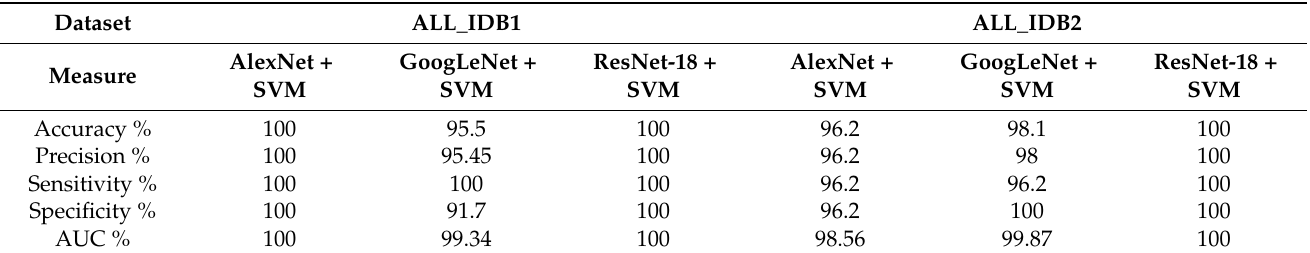
Table 6. The results of the AlexNet, GoogLeNet and ResNet-18 models on the ALL_IDB1 and ALL_IDB2 datasets.